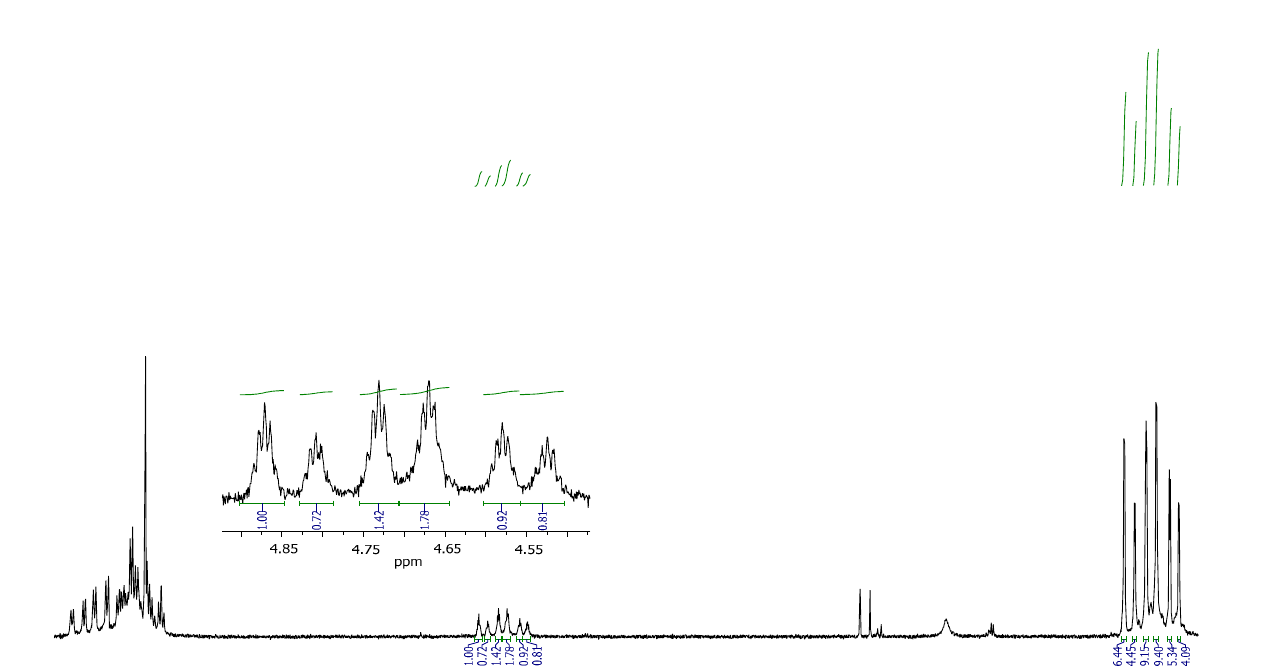
Figure 2. 1 H NMR-spectrum of isomers mixture. According to GPC data, the hydrodynamic radius of isomers in the mixture and of initial cis -tetra[phenyl(dimethylsiloxy)]cyclotetrasiloxane coincide (Figure 3).